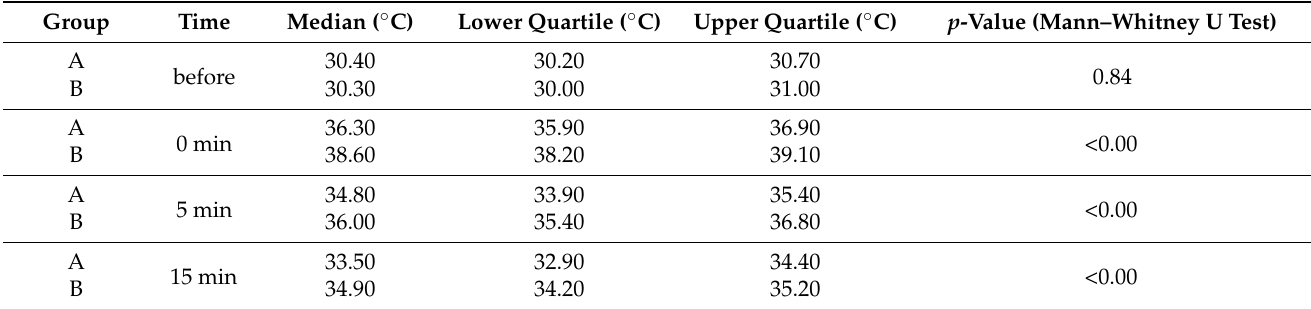
Table 2. Tissue temperature at individual time intervals depending on the electrode used.